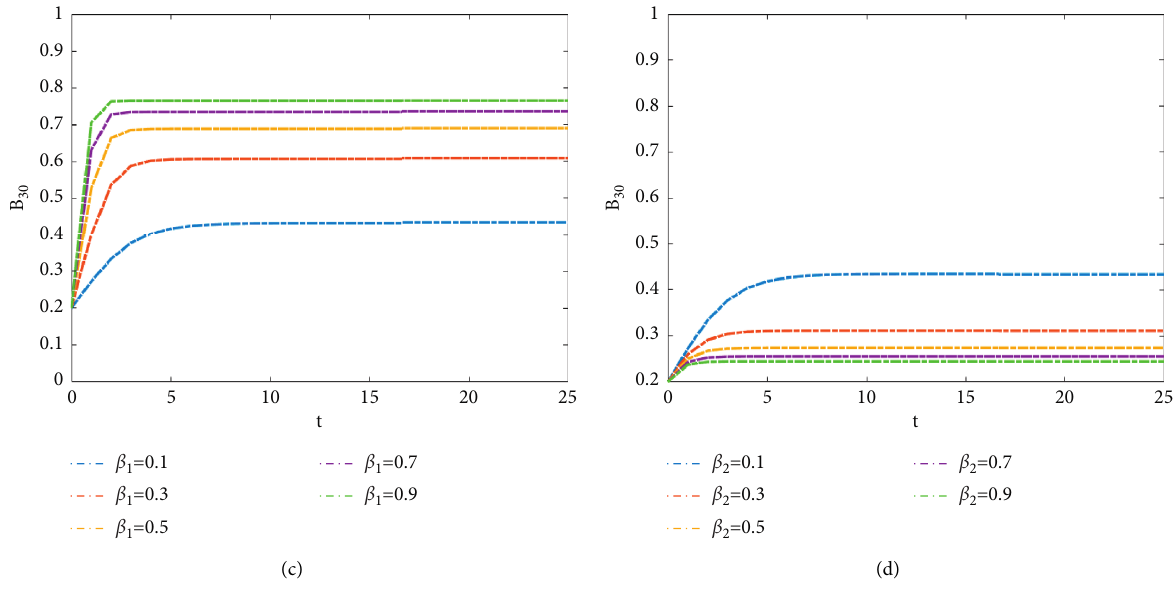
Figure 8: Parameters on the expected probability of buying for node 30: (a) ρ , (b) c , (c) β